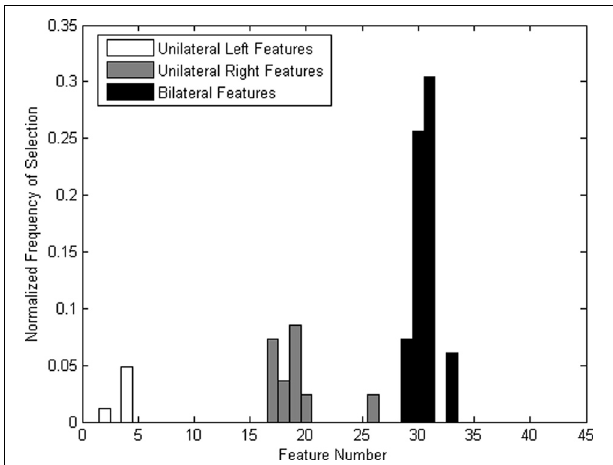
FIGURE 6 | Normalized frequency of features (the number of times a feature has been selected divided by the total number of times all feature have been selected) across all